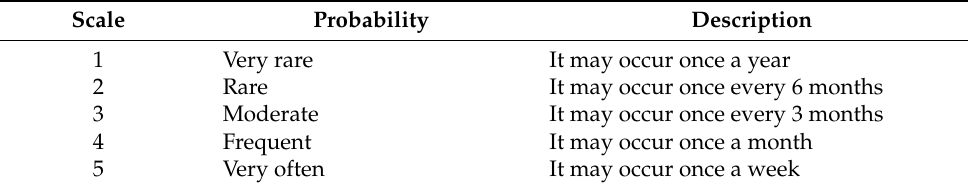
Table 1. The probability scale. Source: Own study. Scale